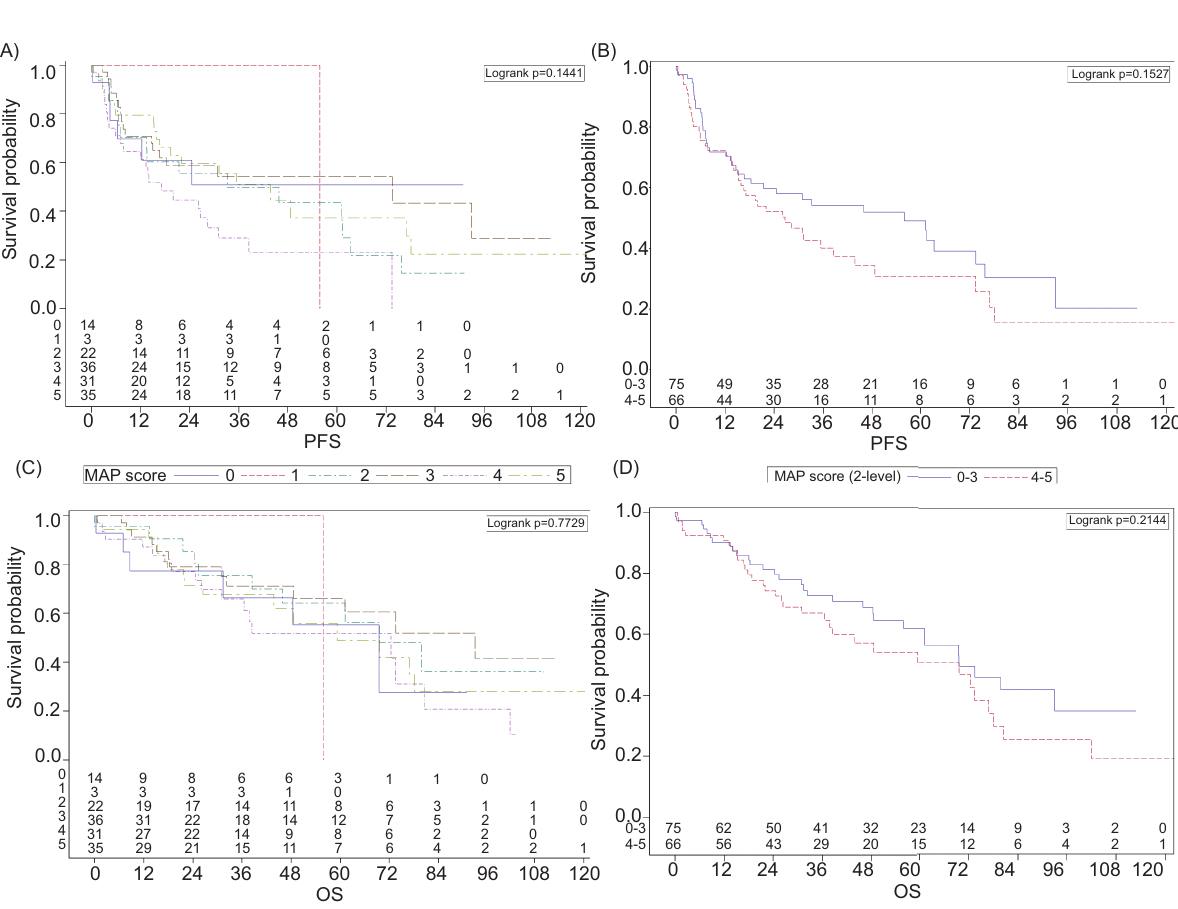
Figure 1: Kaplan–Meier curves for stage T3/T4 renal cell carcinoma patients (n = 141) displaying median progression-free sur- vival (PFS) or overall survival (OS) with either individualized (0–5) or dichotomized (0–3 vs 4–5) Mayo Adhesive Probability (MAP) scores. (A) Median PFS with individualized MAP Scores. (B) Median PFS with dichotomized MAP scores. (C) Median PFS with individualized MAP Scores. (D) Median OS with dichotomized MAP